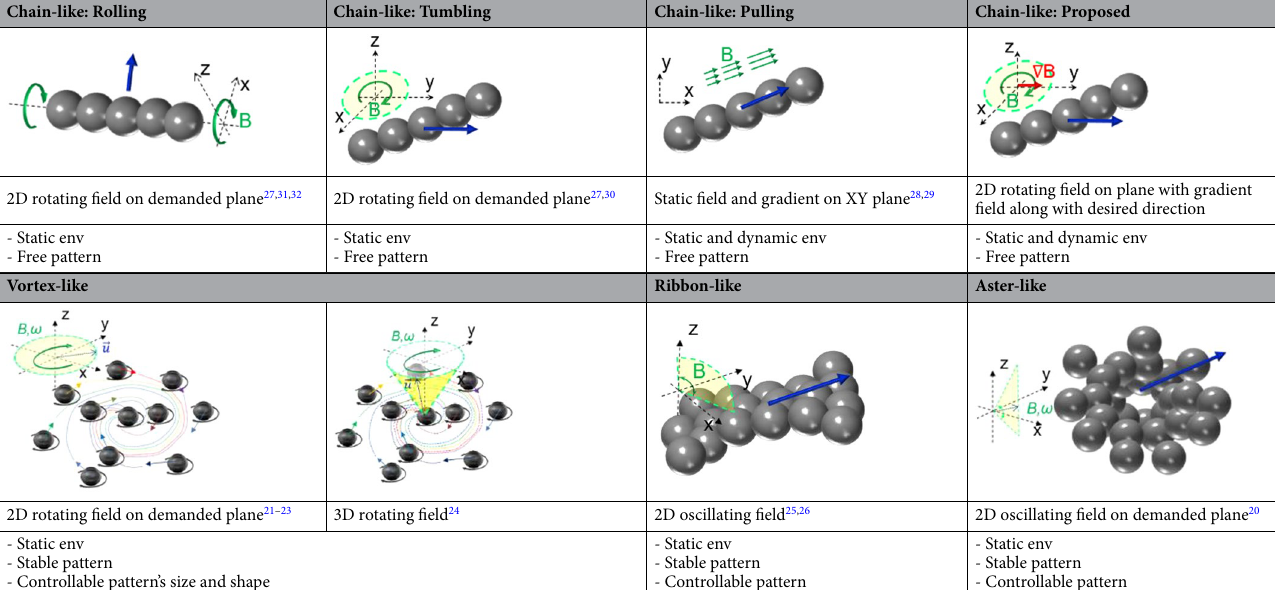
Table 1. Comparison with the existing microrobotic swarm motions.